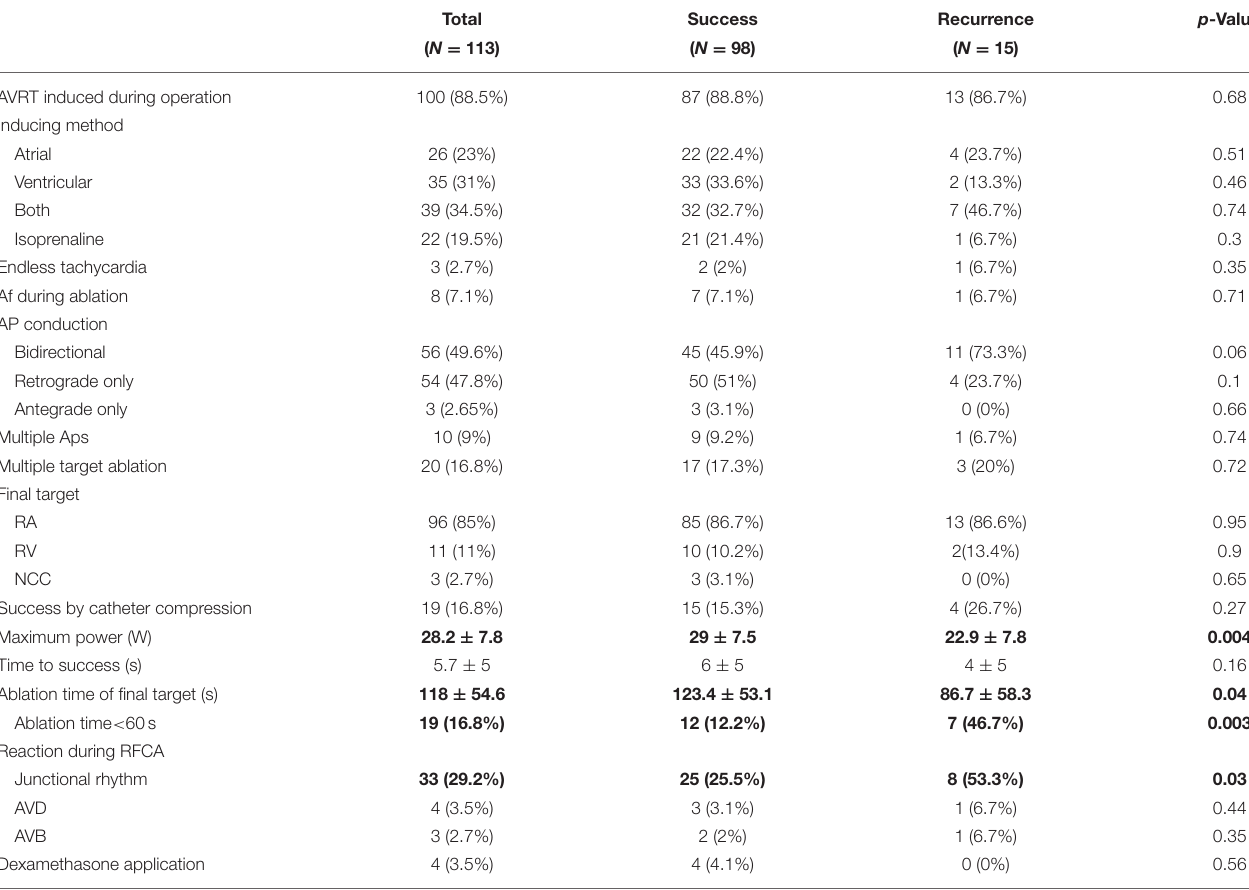
TABLE 2 | EP study and ablation.